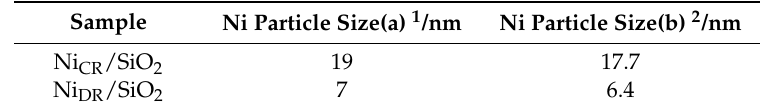
Table 3. Ni particle size of Ni CR /SiO 2 and Ni DR /SiO 2 from TEM and XRD analysis.